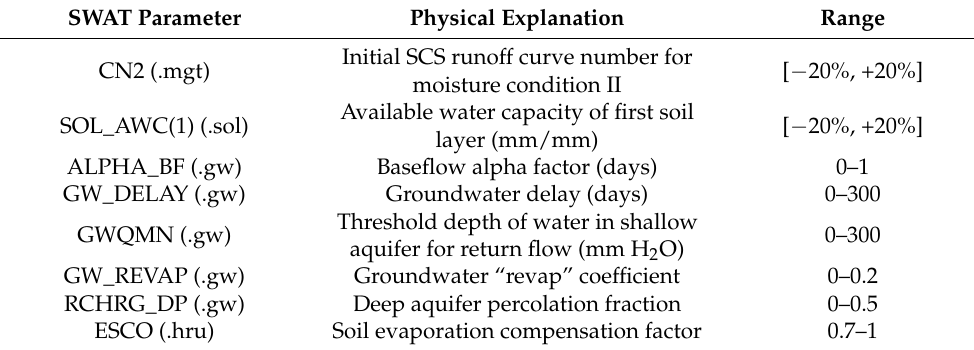
Table 1. Optimized parameters with the SUFI-2 algorithm implemented in